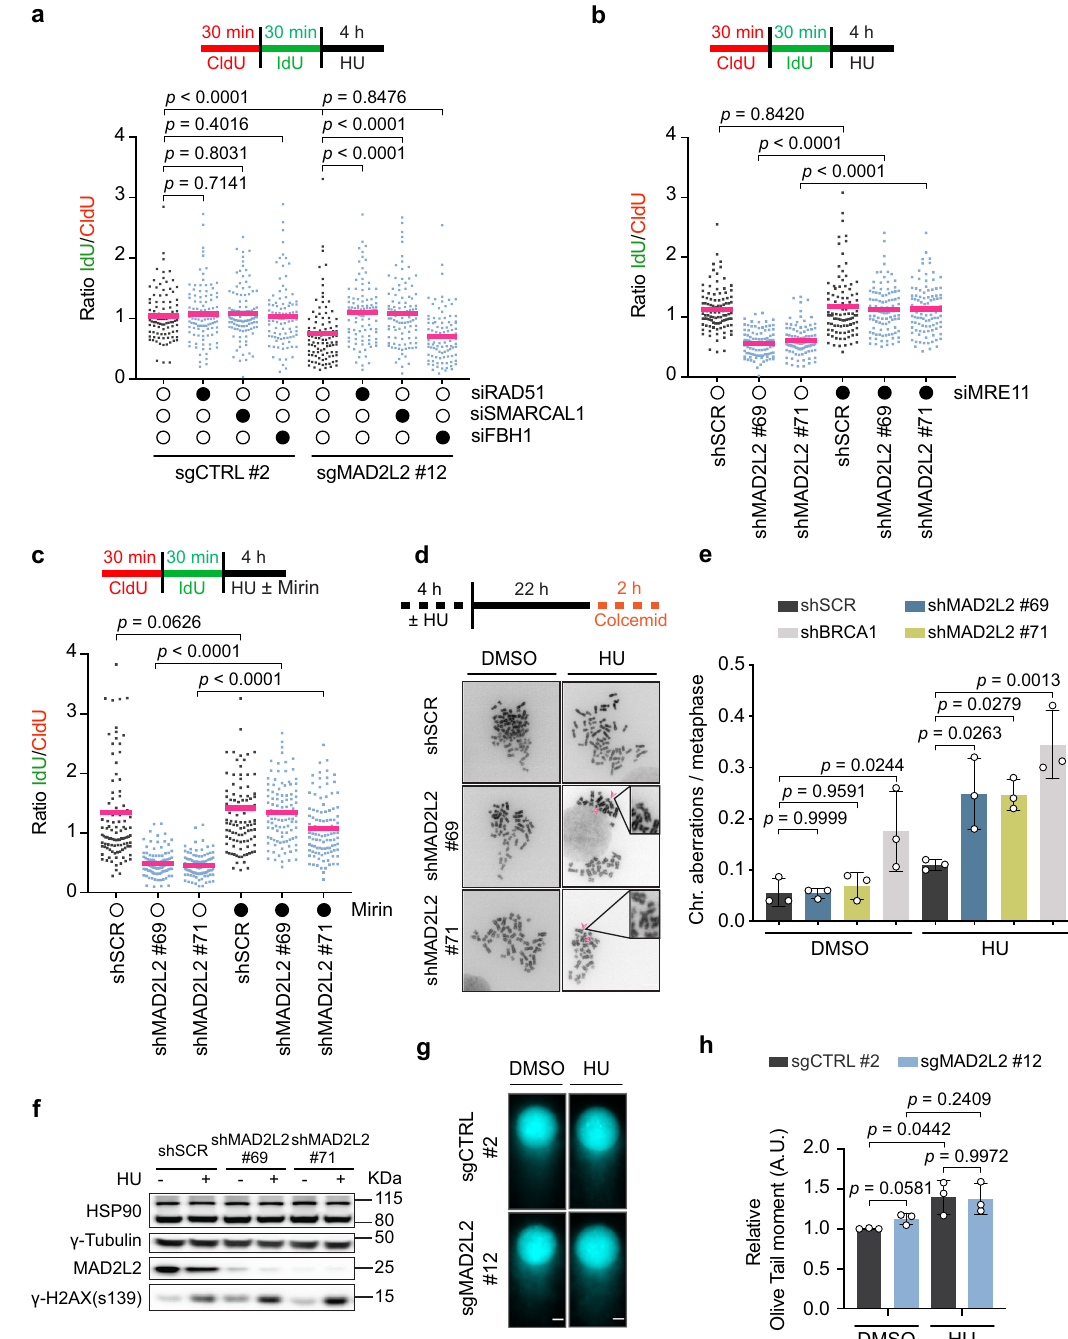
Fig. 3 | The MRE11 nuclease drives reversed fork degradation in MAD2L2- de fi cientcells.a Schematicandquanti fi cationofforkdegradationassaysincontrol (sgCTRL)andMAD2L2-depletedHeLacells,transfectedwithansiRNAcontrol(open circles)ortheindicatedsiRNAs(closedcircles).Cellswereincubatedin4mMHUfor 4h before being harvested. A representative experiment of three independent replicates is shown. b Control (shSCR) and MAD2L2-depleted HeLa cells were transfected with an siRNA control or an siRNA targeting MRE11. Cells were treated and labeled as indicated above. A representative experiment of three independent replicates is shown. c Control (shSCR) and MAD2L2-depleted HeLa cells were labeledasindicatedaboveandsubsequentlytreatedwith4mMHU,withorwithout the MRE11 inhibitor mirin (50 μ M) for 4h. A representative fi ber experiment from three independent biological replicates is shown. d Schematic and representative images of metaphase spreads in control (shSCR), MAD2L2-depleted, and BRCA1- depletedHeLacellsfollowingtreatmentwith4mMHUfor4handrecoveryfor24h. Arrows indicate chromosome/chromatid breaks. Scale bar, 10 μ M. e Quanti fi cation